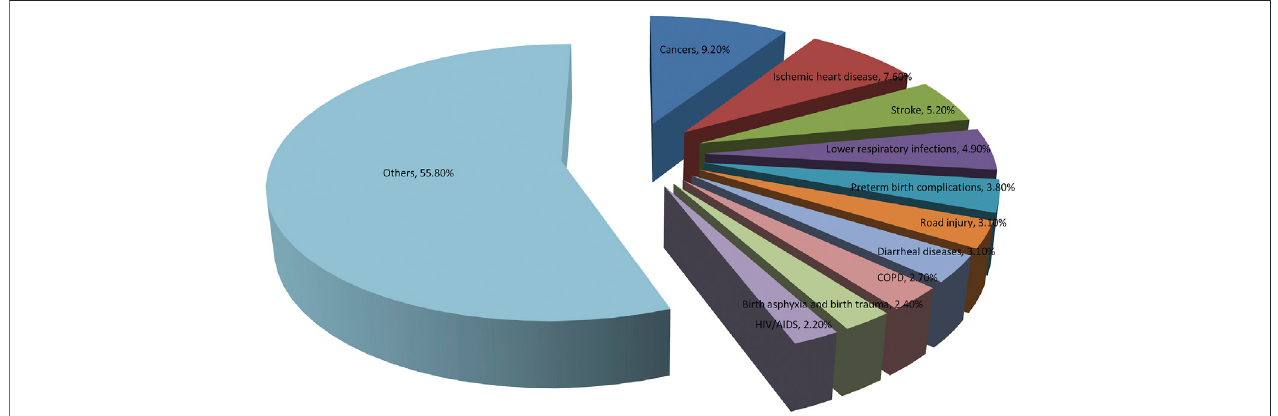
FIGURE 1 | World Health Organization (WHO) Global Health Estimates 2019 on the 10 leading causes of disease burden, estimated as cause-speci fi c Disability Adjusted Life Years (DALYs). Cancer has become the leading causes of disease burden by cause-speci fi c disability adjusted life years.